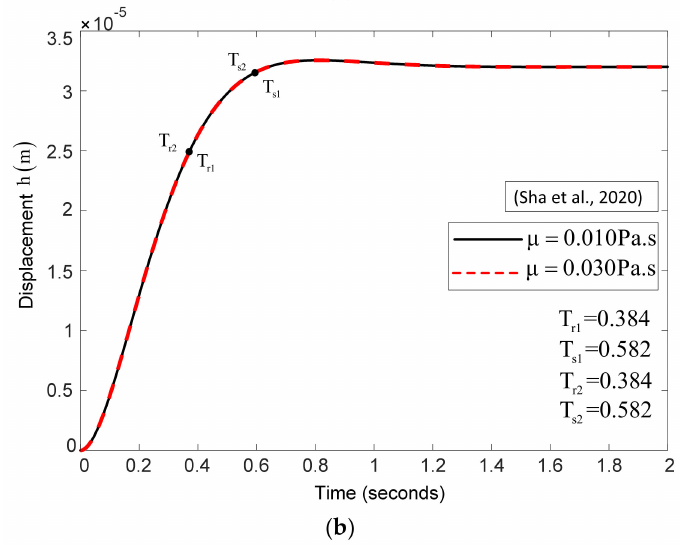
Figure 8. Tracking performance under different viscosity. ( a ) Present study. ( b ) Literature research work.